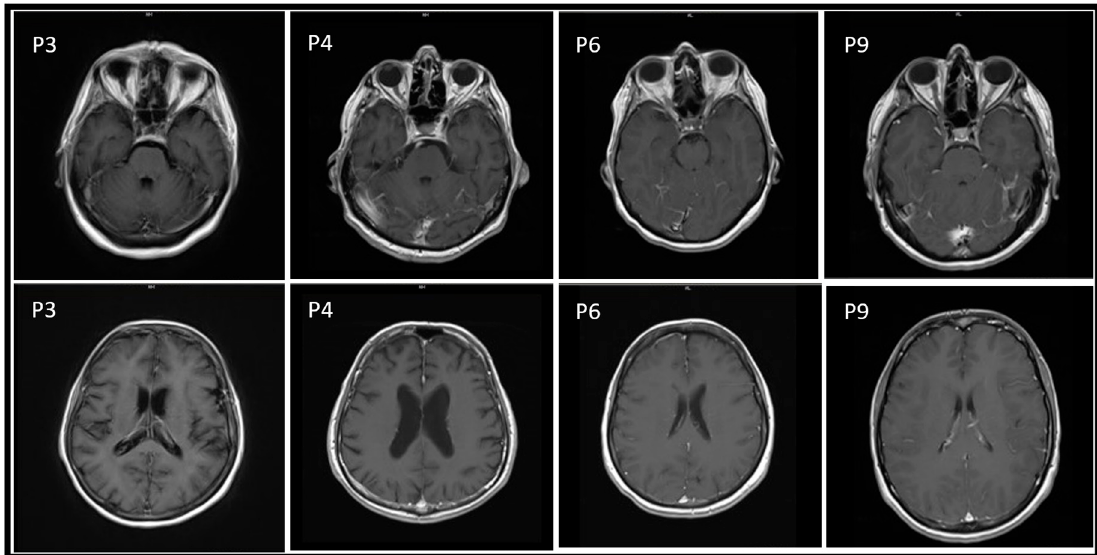
Figure 1. Main MR findings of patients. Axial contrast-enhanced image shows meningeal increased signal intensity accordingly to the clinical suspect of meningitis in patients 3, 4, 6 and 9 (respectively, P3, P4, P6 and P9).